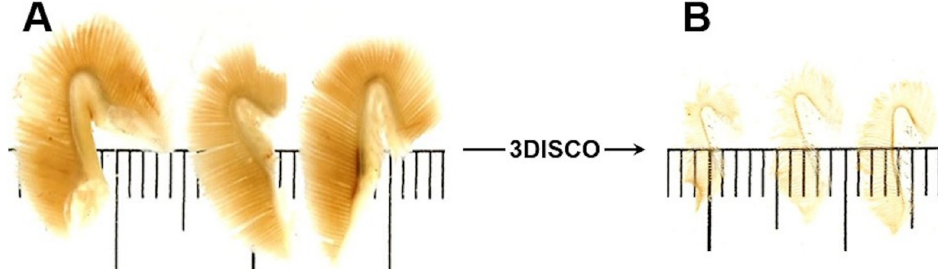
Fig 16. Optical clearing of rainbow trout gills. A. Formalin-fixed (non-transparent) rainbow trout gills, placed on a mm ruler. B. The identical gills after optical tissue clearing with the 3DISCO protocol. Note the transparency and the shrinkage of the cleared gills. Note that the images in A and B show intact gills (with gill arches). For LSFM-based quantitative morphological analyses, the gill arches are removed from the gills and the gill filaments are cleared after determination of their weight or